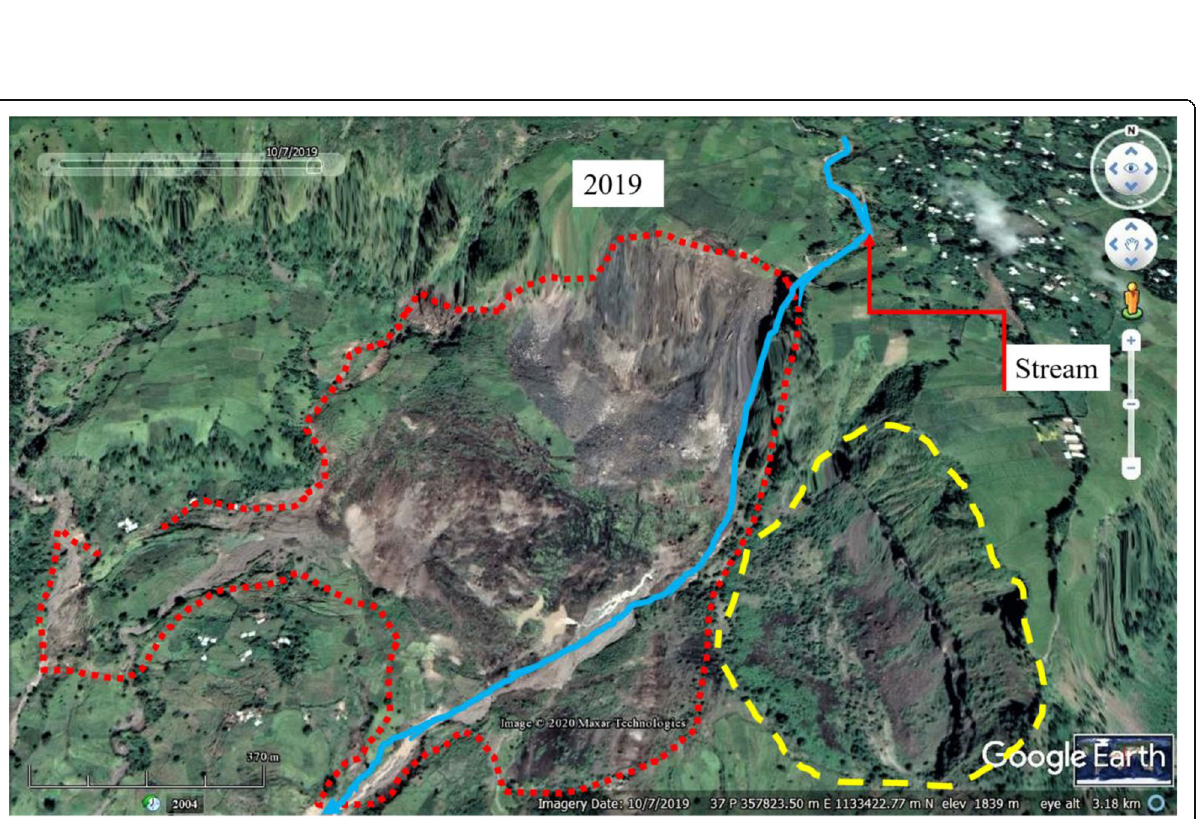
Fig. 6 Time series Google Earth Image shows failed slope at Desa Enese village in 2019